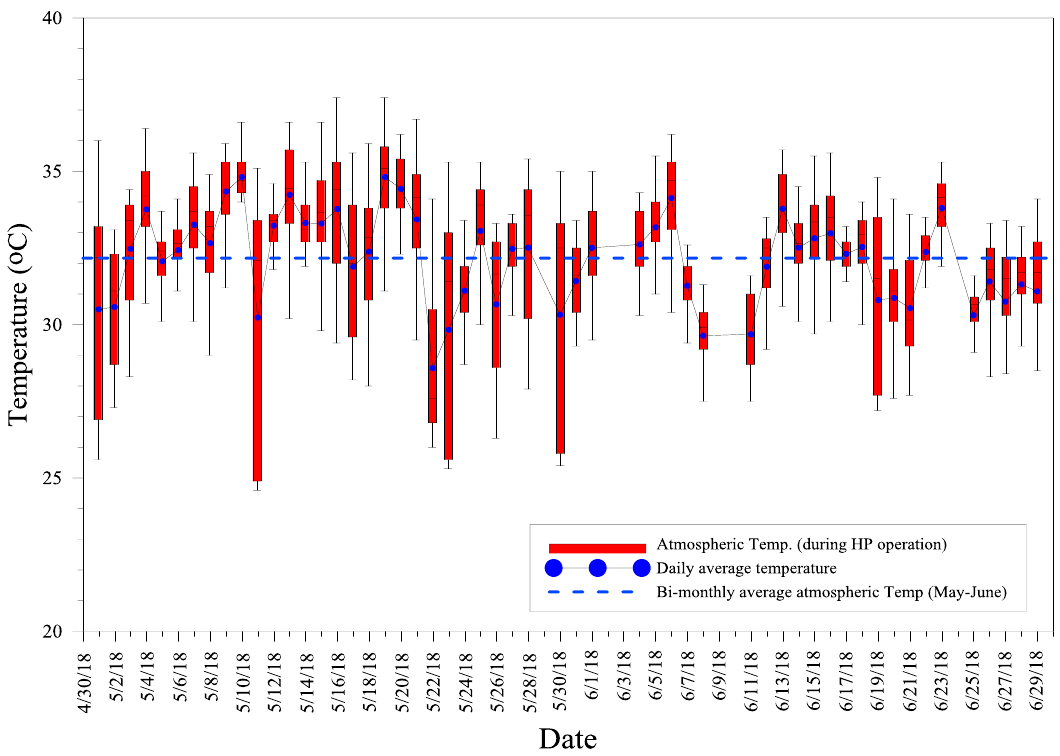
Figure 10. Atmospheric temperature variation during the heat pump operation.